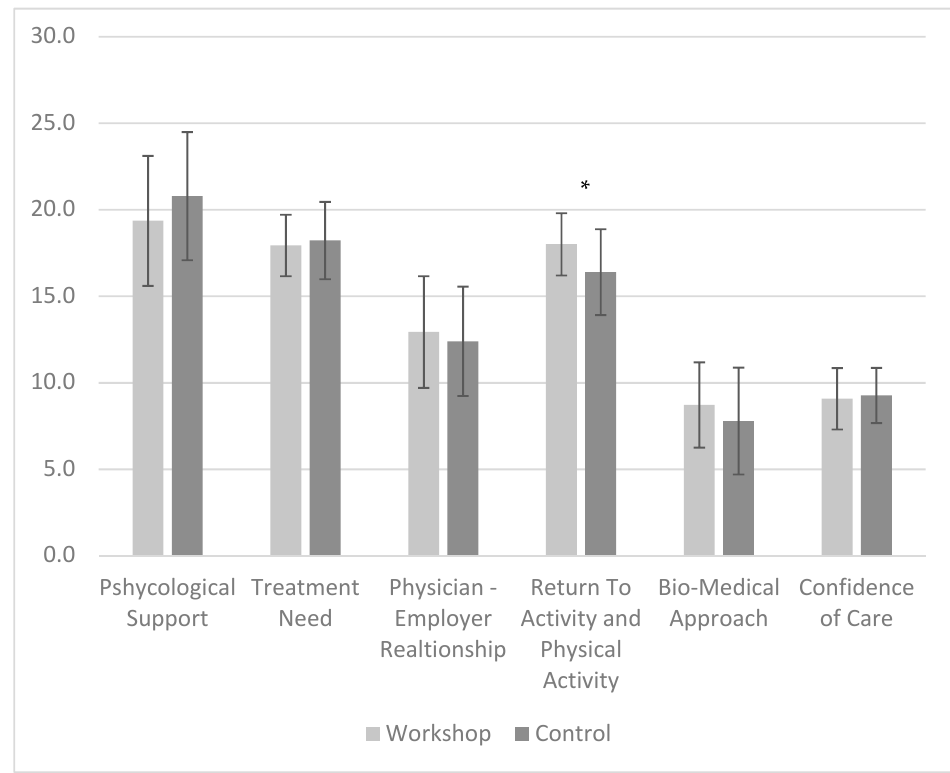
Figure 3. ABS-mp’s mean scores for every sub-scale following the ETMI workshop in both physicians’ groups. * Statistically significant difference ( t = 2.107, p = 0.042).